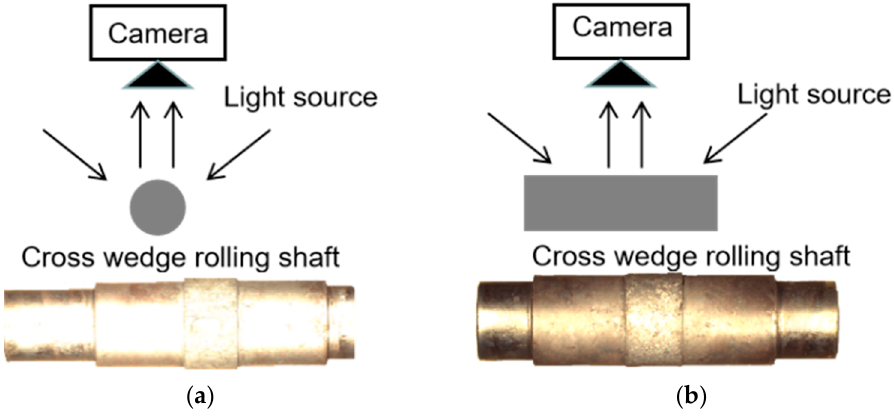
Figure 3. Comparison of images acquired by two lighting methods. ( a ) Circumferential illumination; ( b ) axial illumination.